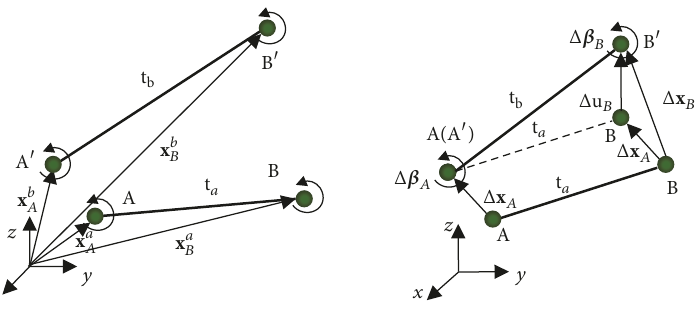
Figure 3: Particle displacement.